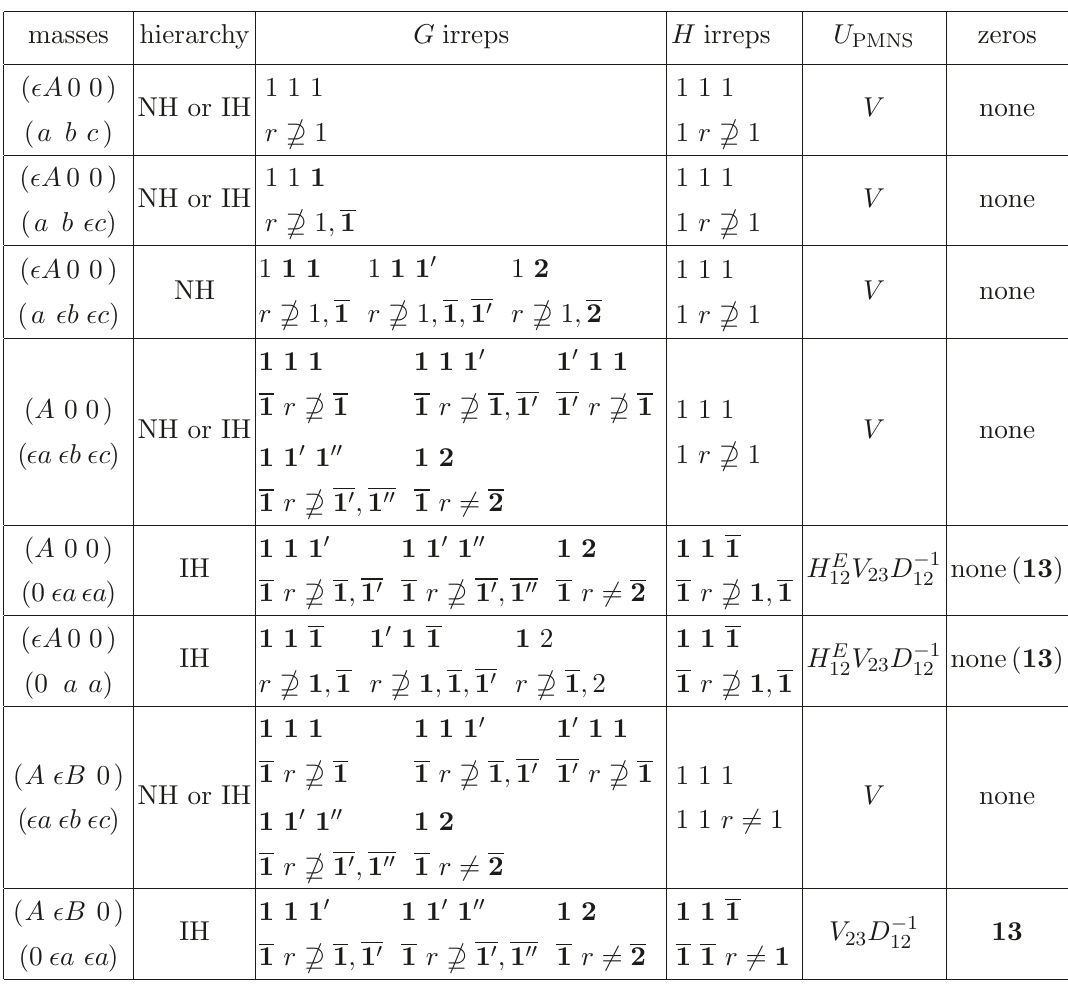
H , under the hypothesis → leading and of U H , U H , U G e c e c l l coincide with those shown in that , U H e c l